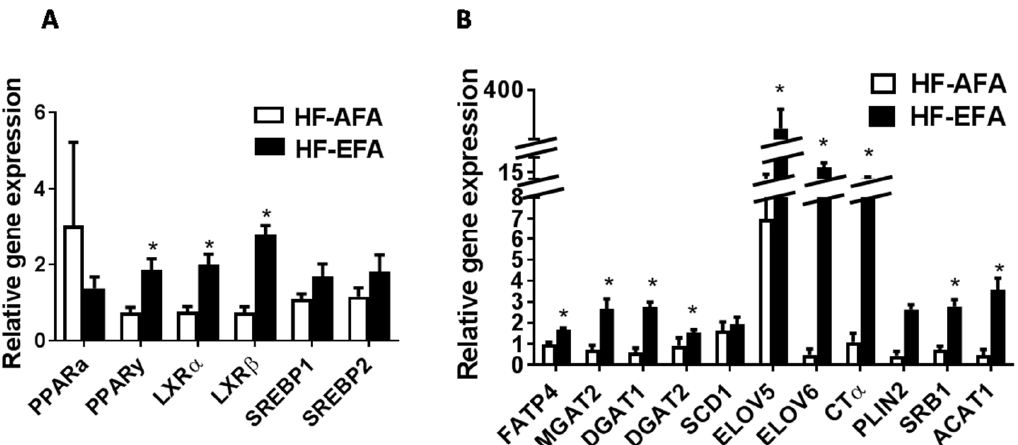
Figure 5. Gene expression analysis in adipose tissue of HF ‐ EFA shows increased levels of lipogenic mediators. Relative mRNA levels of ( A ) transcription factors and ( B ) genes involved in lipid synthesis, storage and transport, in adipose tissue of HF ‐ AFA and HF ‐ EFA fed rats. Values are means ± SEM, * p < 0.05.